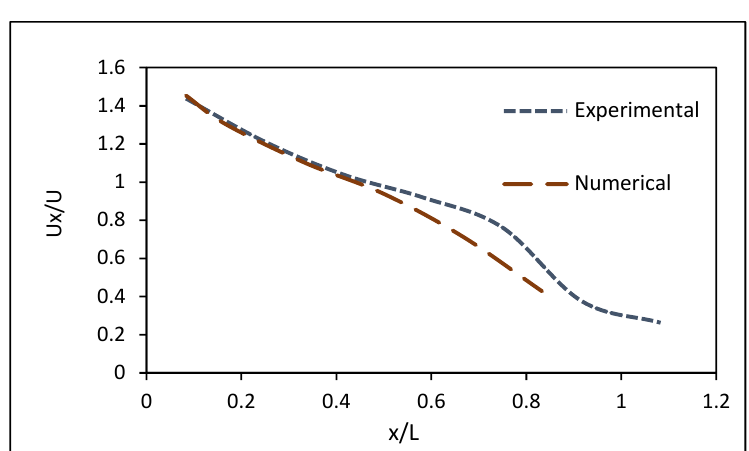
Figure4. Comparison of the normalized velocity-length profiles obtained from the mathematical and Bagheri et al.'s laboratory [22] model